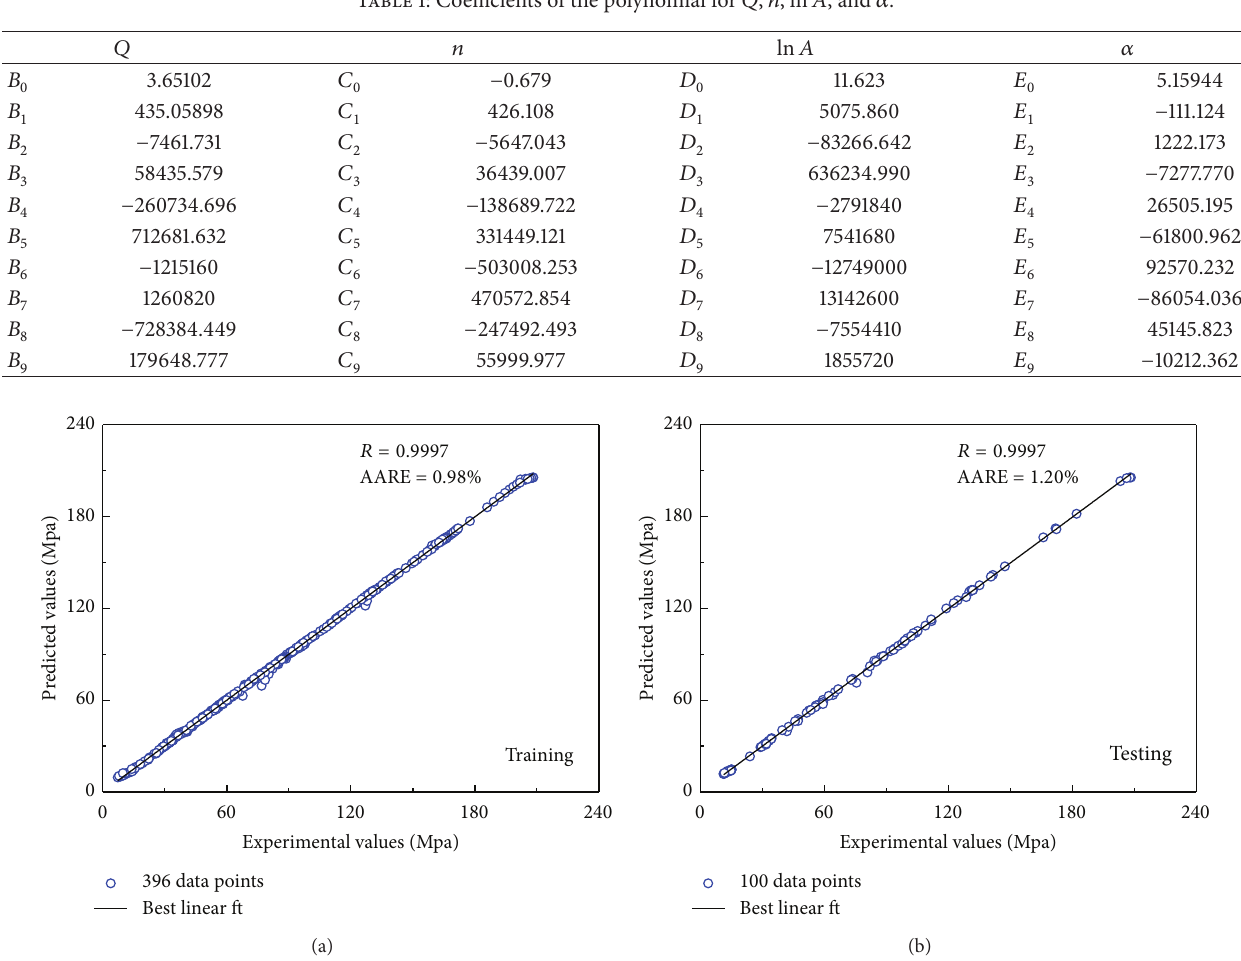
Table 1: Coefficients of the polynomial for 𝑄 , 𝑛 , ln 𝐴 , and 𝛼 .